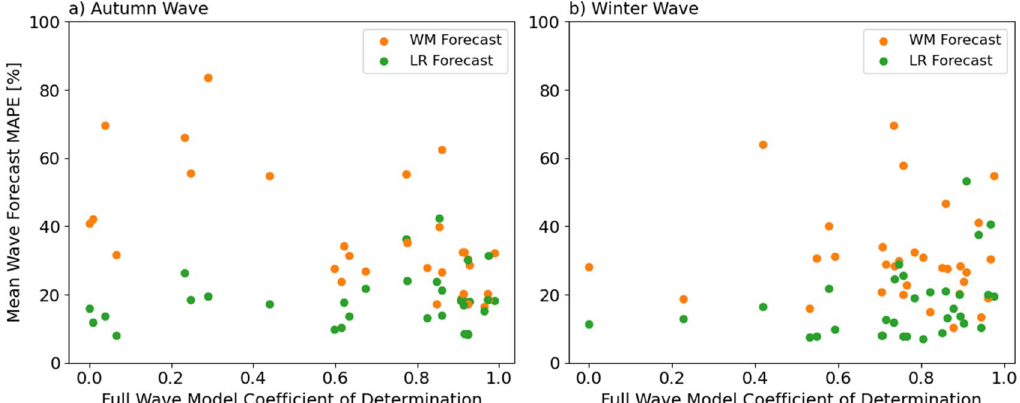
Figure 8. Relationship between the Wave Model coefficient of determination for each WWTP and full contagion wave and the respective mean MAPE for each short-term forecast method (Wave Model with increasing fitting window and linear model with 2-week fitting window). The short-term forecast linear model performed better for those sites where the Wave Model of the full contagion wave showed a low coefficient of